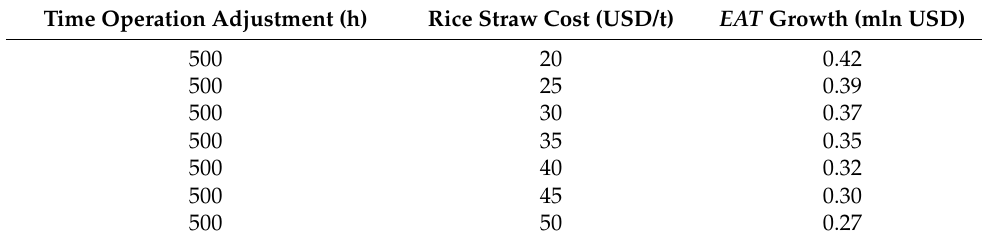
Table 10. The growth of EAT when adjusting 500 h of time